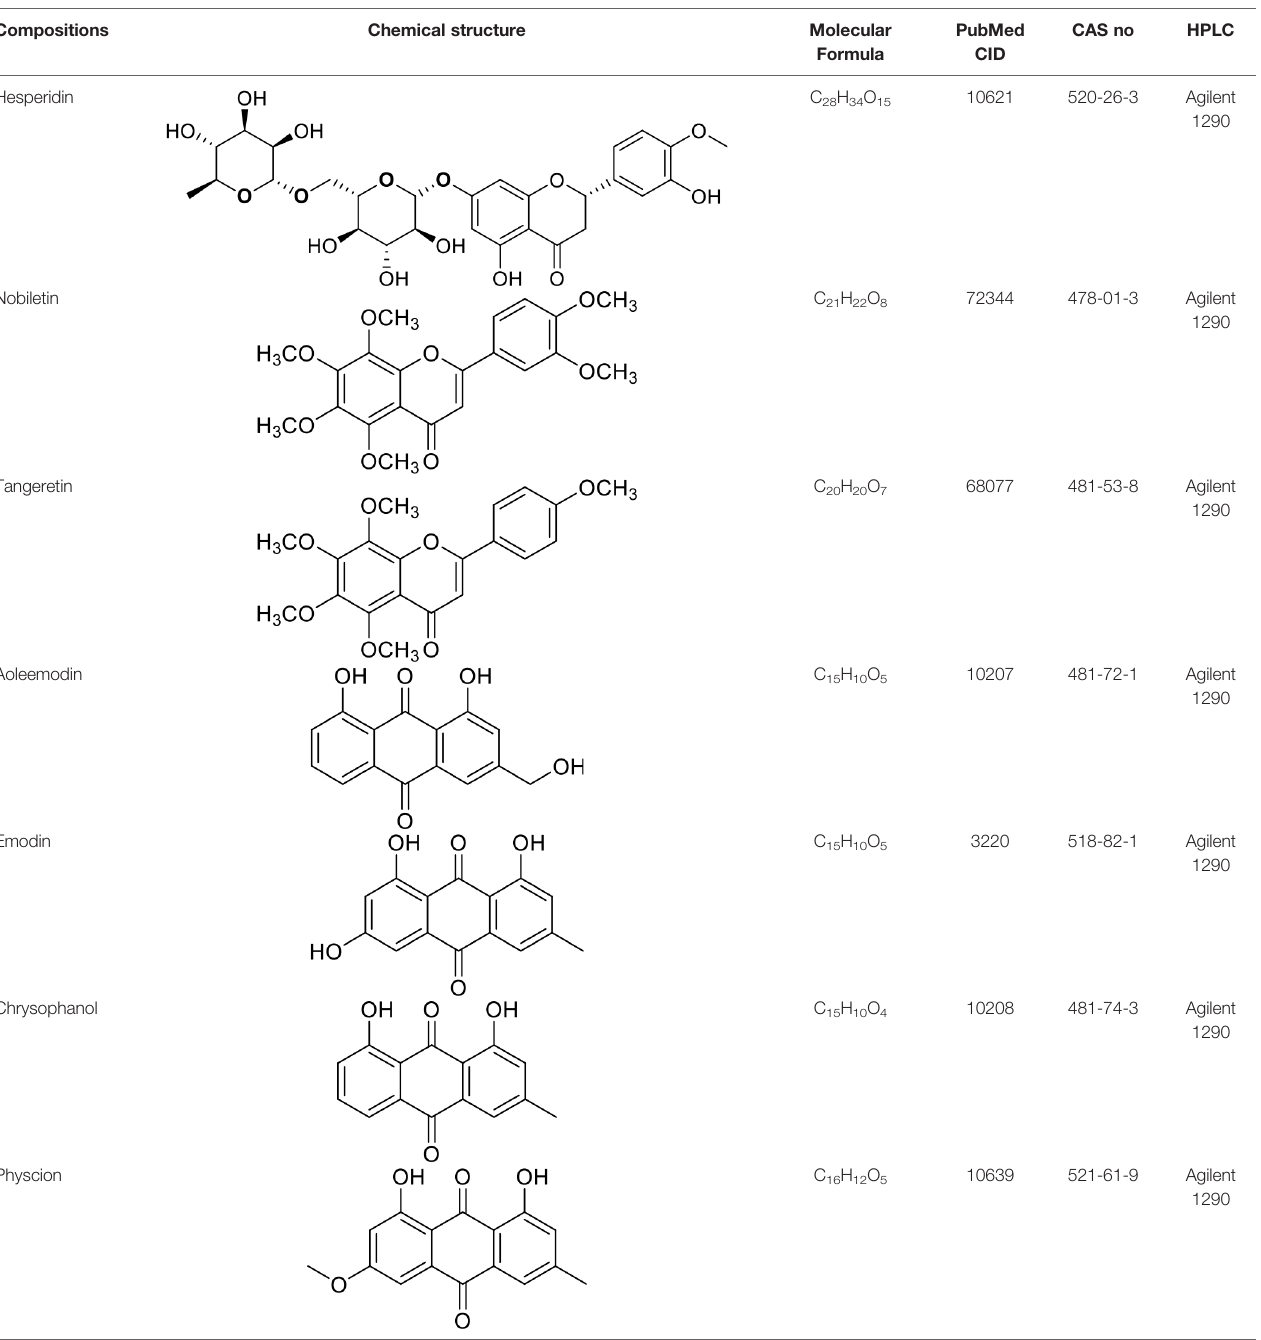
TABLE 5 | Primary chemical compositions of